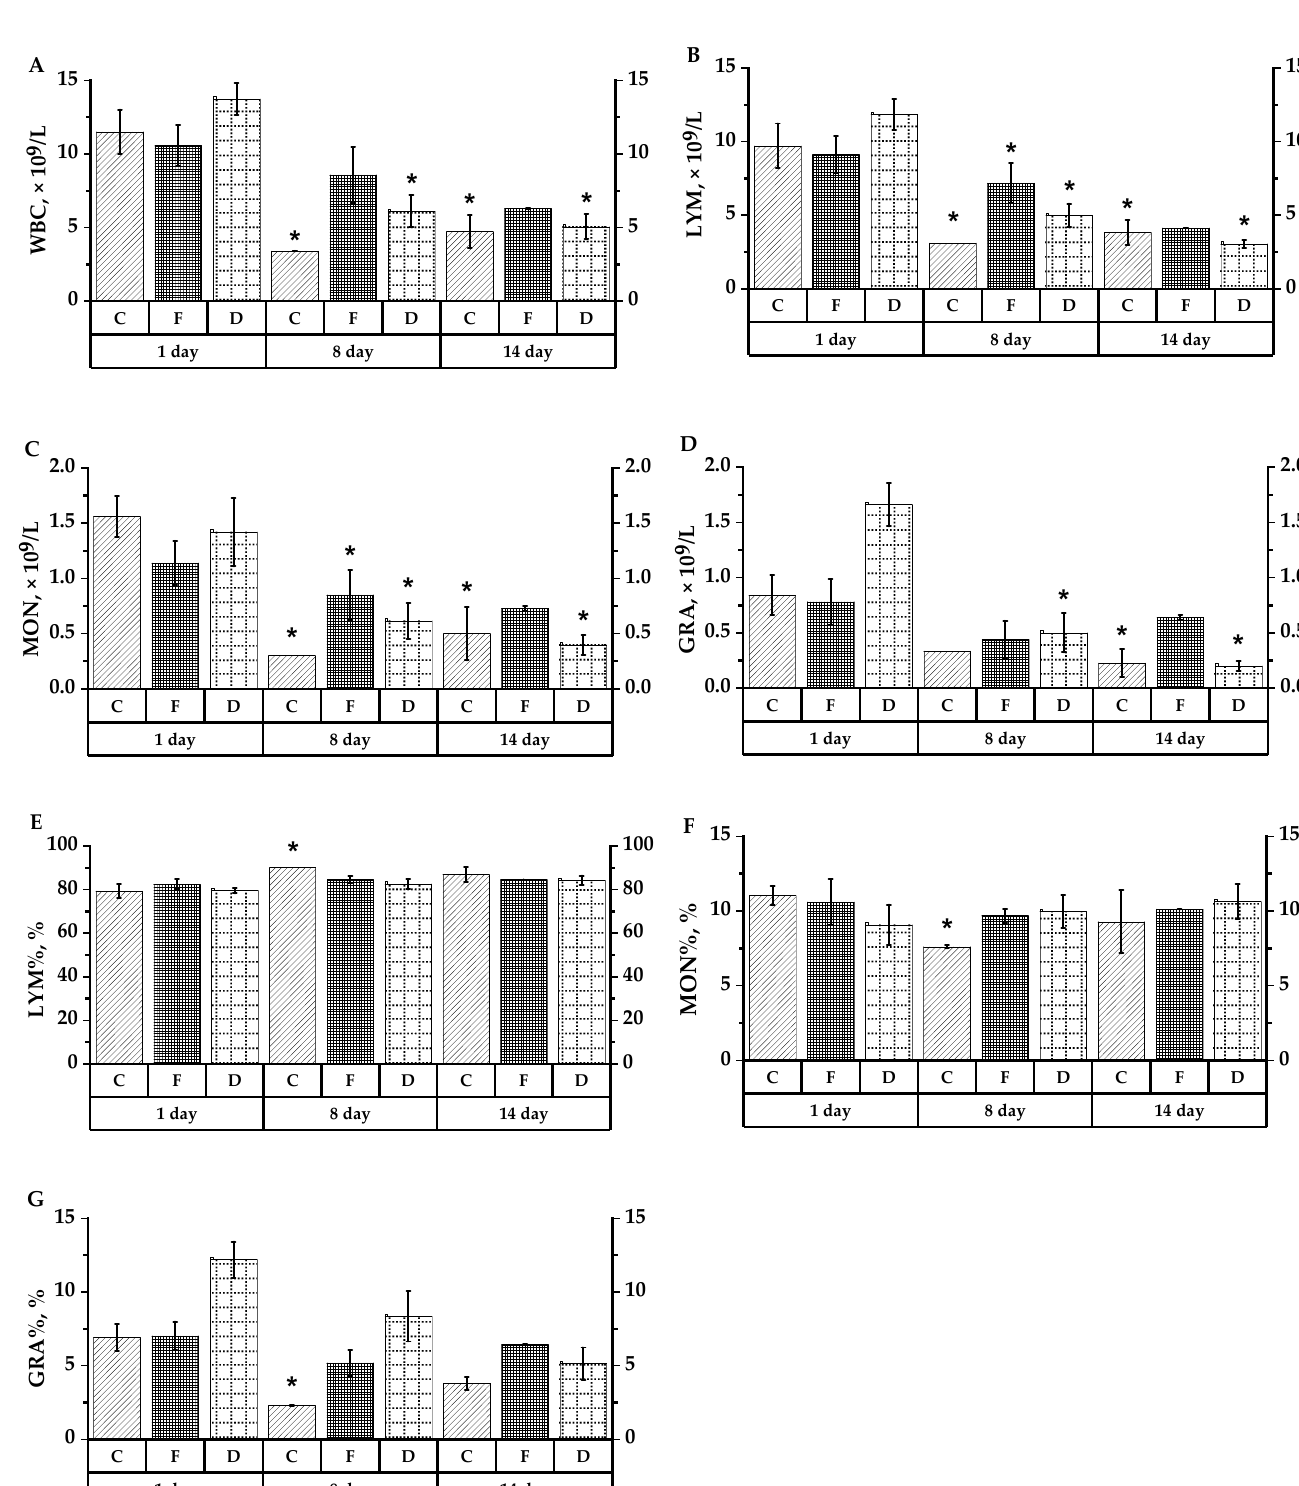
Figure 4. The main indices for hematological analysis of laboratory animals’ whole blood of groups C, D and F. ( A ) White blood count (WBC); ( B ) lymphocyte count (LYM); ( C ) monocyte count (MON); ( D ) neutrophil granulocyte count (GRA); ( E ) lymphocyte relative values from total leukocyte count (LYM%); ( F ) monocyte relative values from total leukocyte count (MON%); ( G ) granulocyte relative values from total leukocyte count (GRA%). * ( p < 0.05)—reliability of differences in animal groups compared to 1 experimental day. The values are the means from three independent experiments ±